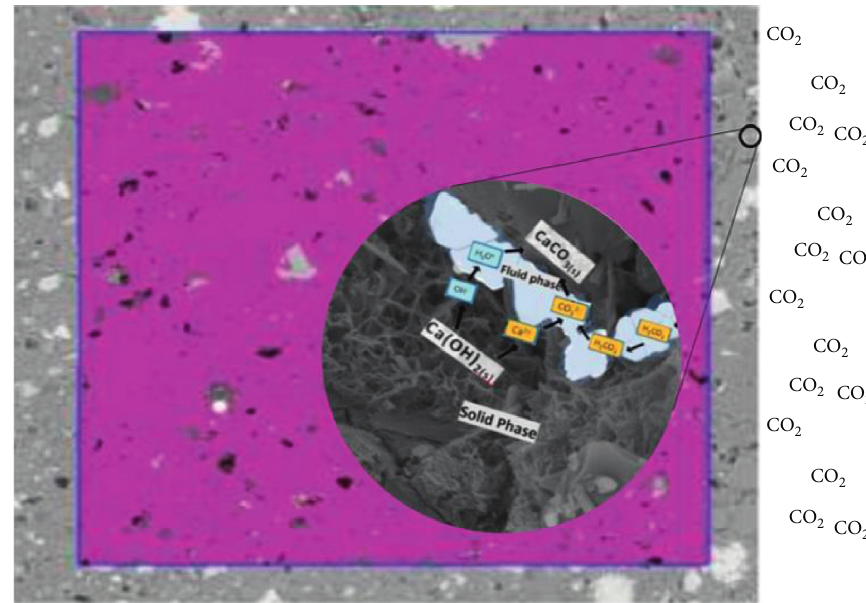
Figure 12: Mechanism of carbonation at the pore level and pH profile along the CO